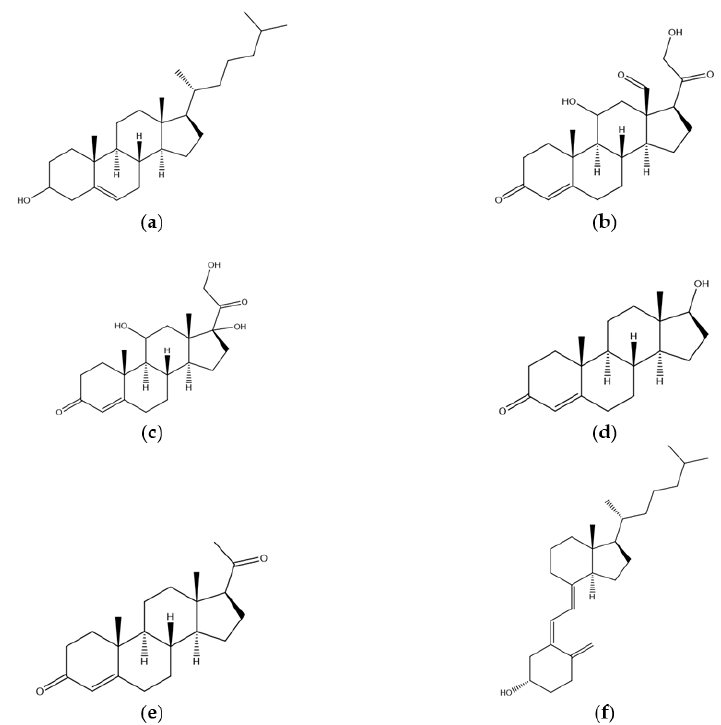
Figure 2. 2D structures of: ( a ) cholesterol; and some of its precursors: ( b ) aldosterone; ( c ) cortisol; ( d ) testosterone; ( e ) progesterone; and ( f ) vitamin-D3.